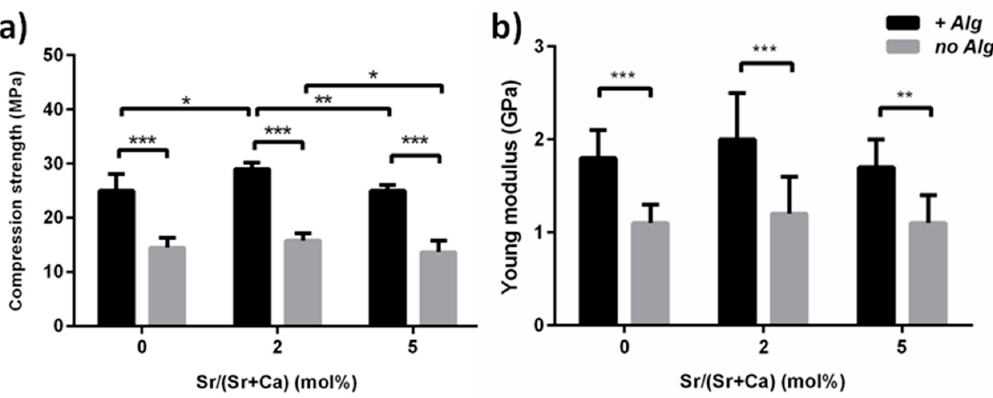
Figure 6. Effect of alginate on the compressive strength ( a ) and Young’s modulus ( b ) of Sr-doped cements after three days of immersion. * p < 0.5; ** p < 0.1; *** p < 0.01.